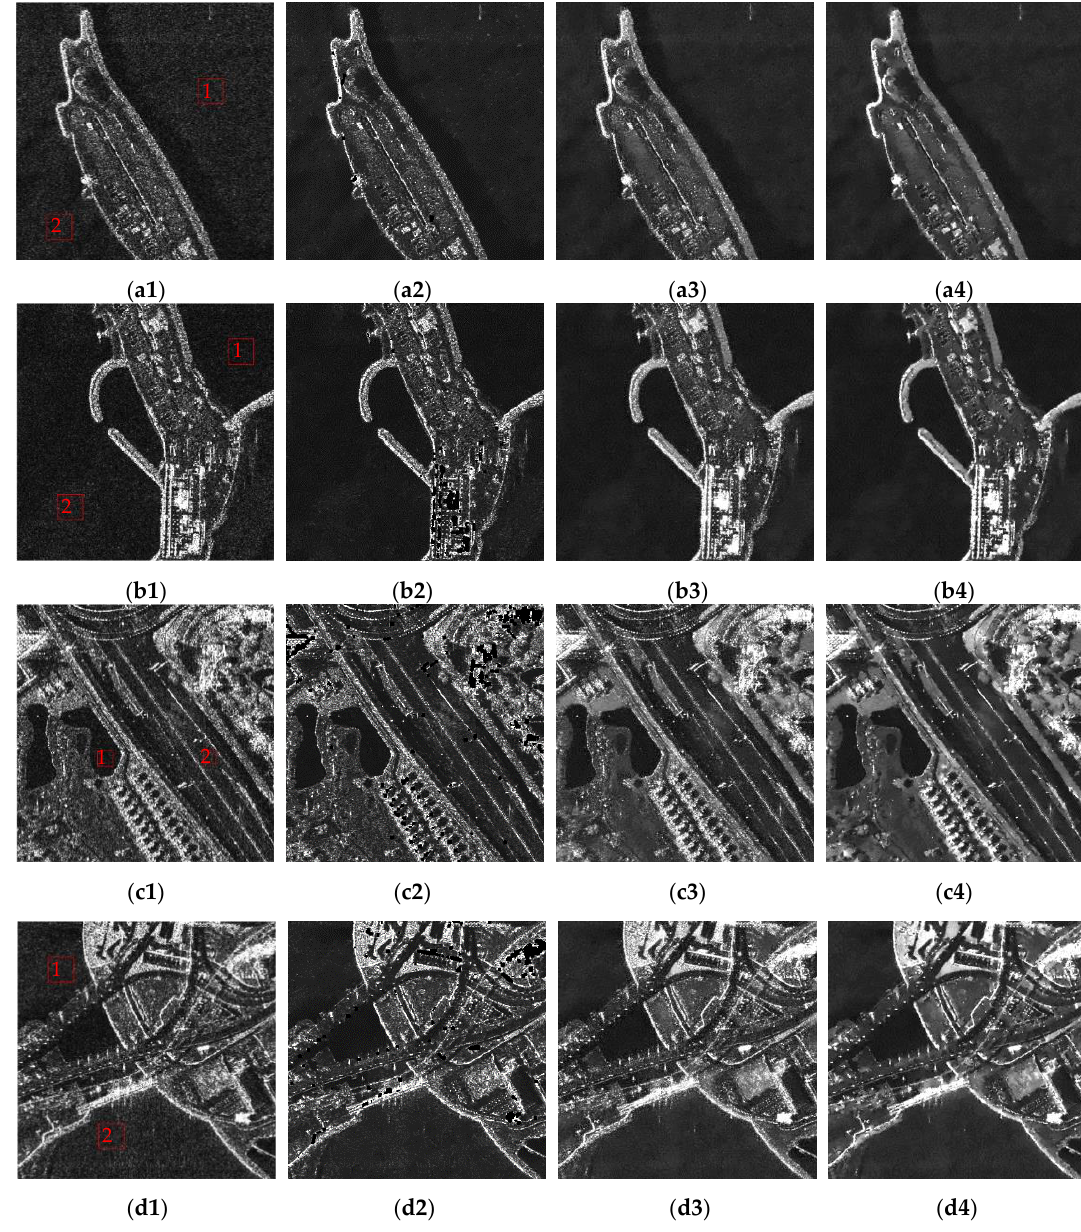
Figure 8. Despeckling results. ( a1 ), ( b1 ), ( c1 ) and ( d1 ) show raw SAR images. ( a2 ), ( b2 ), ( c2 ) and ( d2 ) illustrate results obtained by the fast non-local algorithm. ( a3 ), ( b3 ), ( c3 ) and ( d3 ) illustrate results obtained by the conventional PPB algorithm. ( a4 ), ( b4 ), ( c4 ) and ( d4 ) illustrate results obtained by the proposed three-step algorithm.